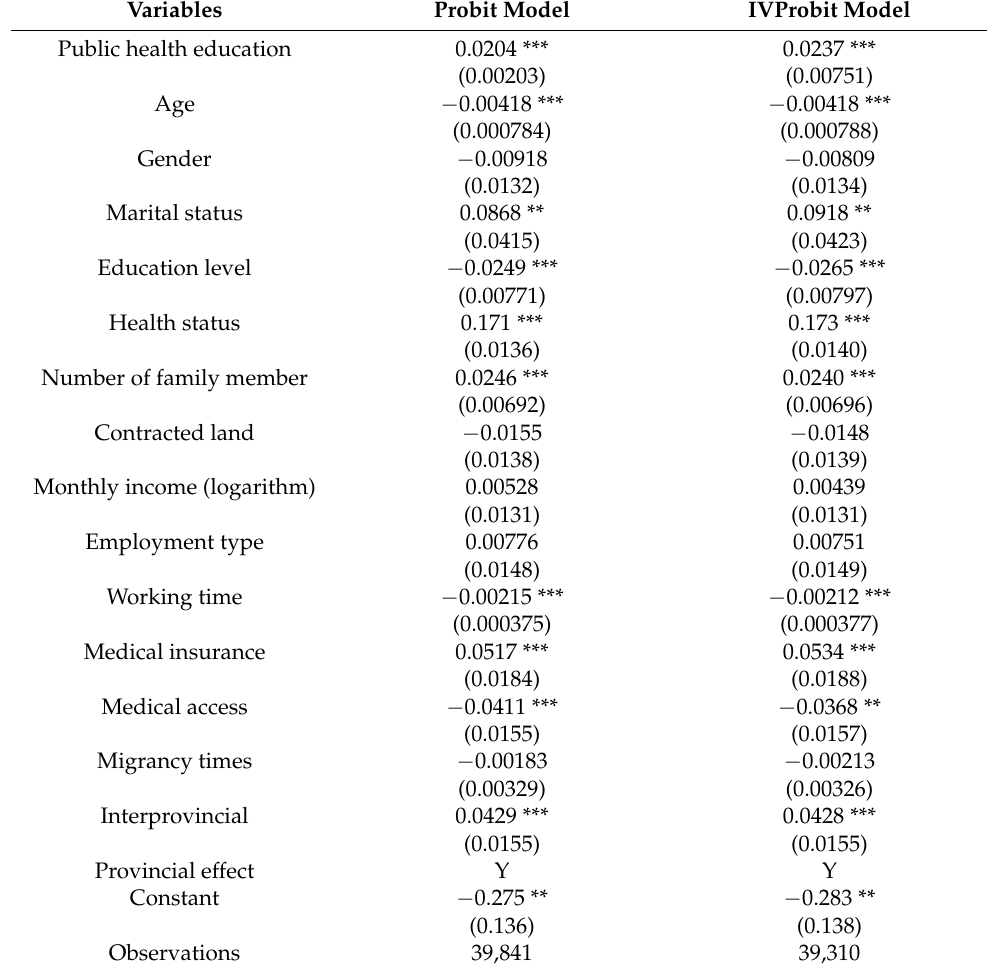
Table 2. The impact of public health education on migrant workers’ medical service